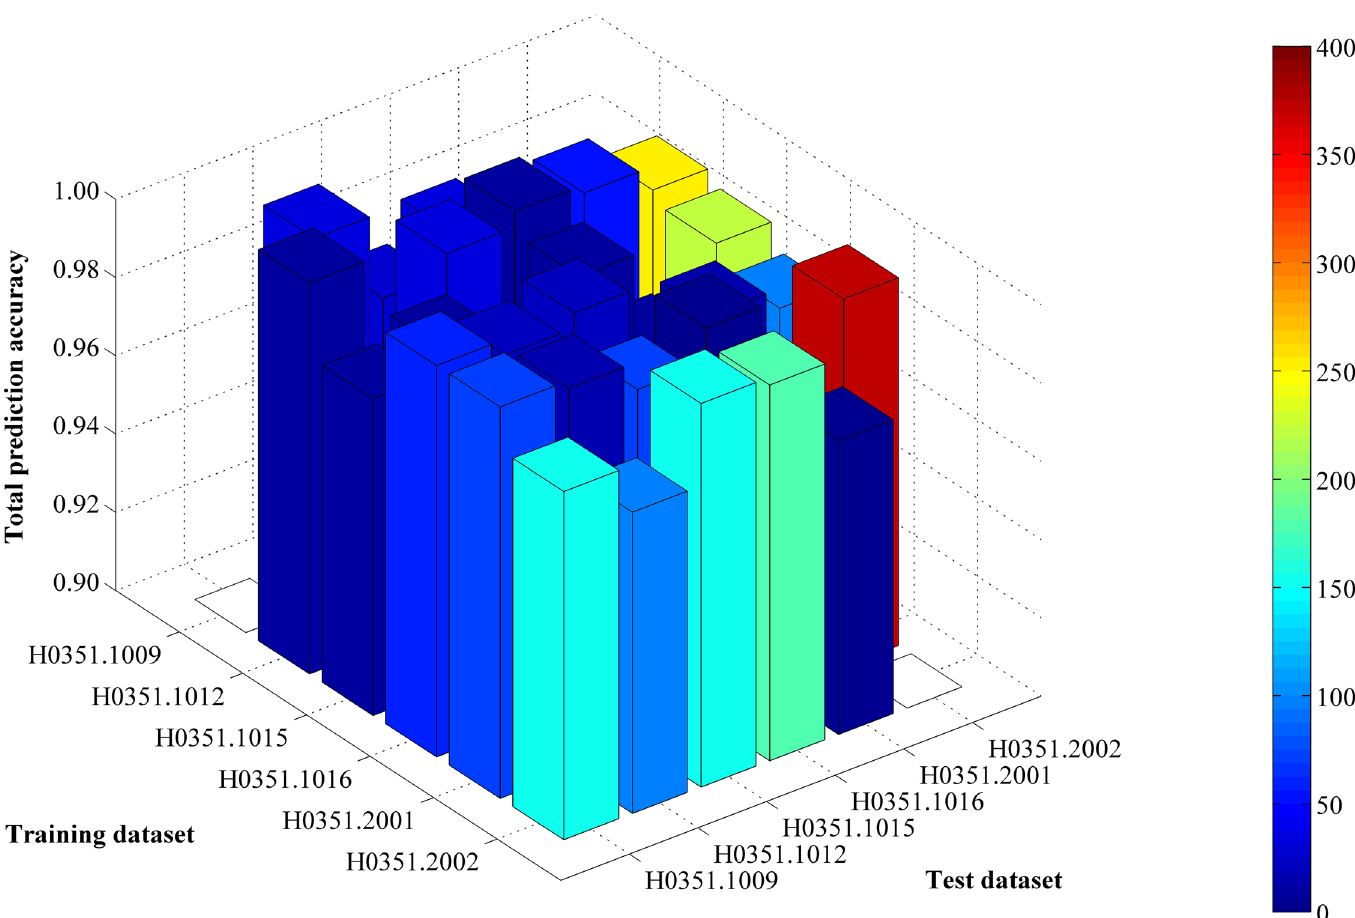
Fig 1. A 3-D histogram illustrating the number of features in the feature set yielding the maximum total prediction accuracy and the corresponding total prediction accuracy. The height of the bar represents the maximum total prediction accuracy, whereas the color of the bar represents the number of features in the feature set yielding the maximum total prediction